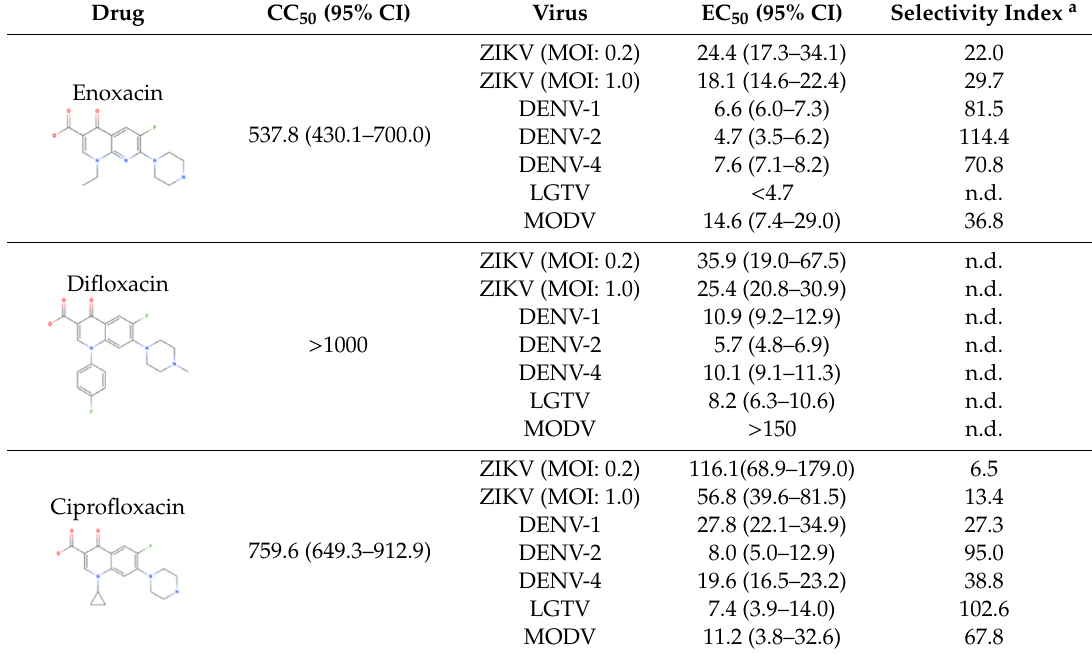
Table 3. Potency and toxicity of enoxacin, difloxacin, and ciprofloxacin against flaviviruses in HEK-293 cells.